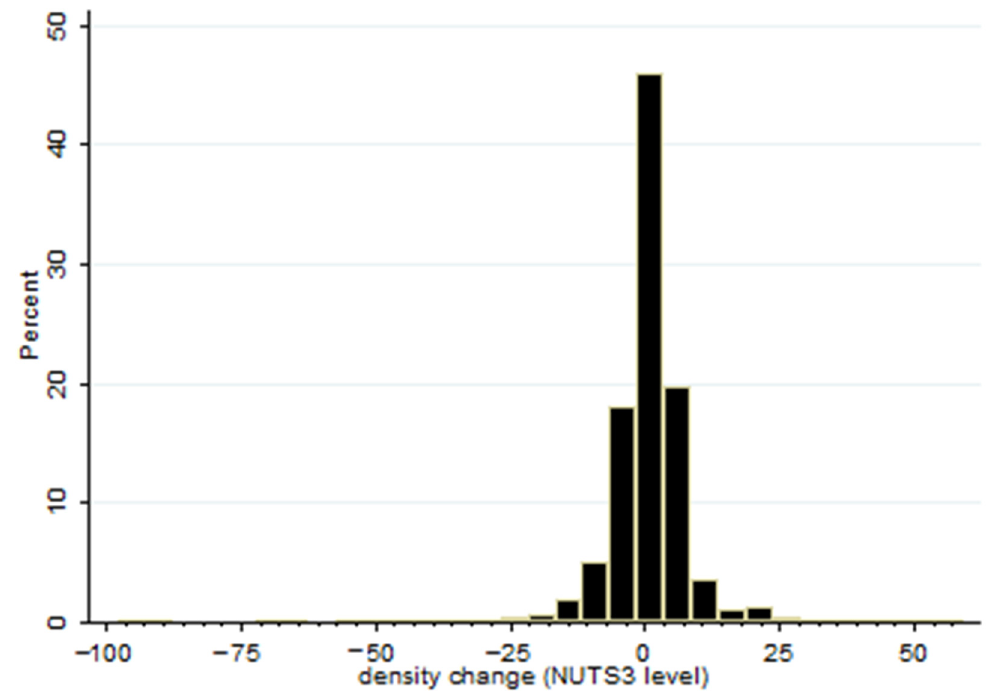
Figure 4. Frequency distribution of the most common density changes observed between 2000 and 2010 for all the EU countries.